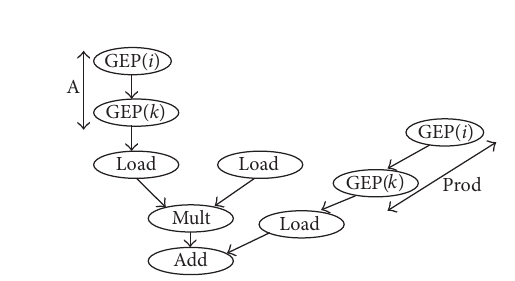
Figure 4: Directed acyclic graph (DAG) of IR for matrix scaling.